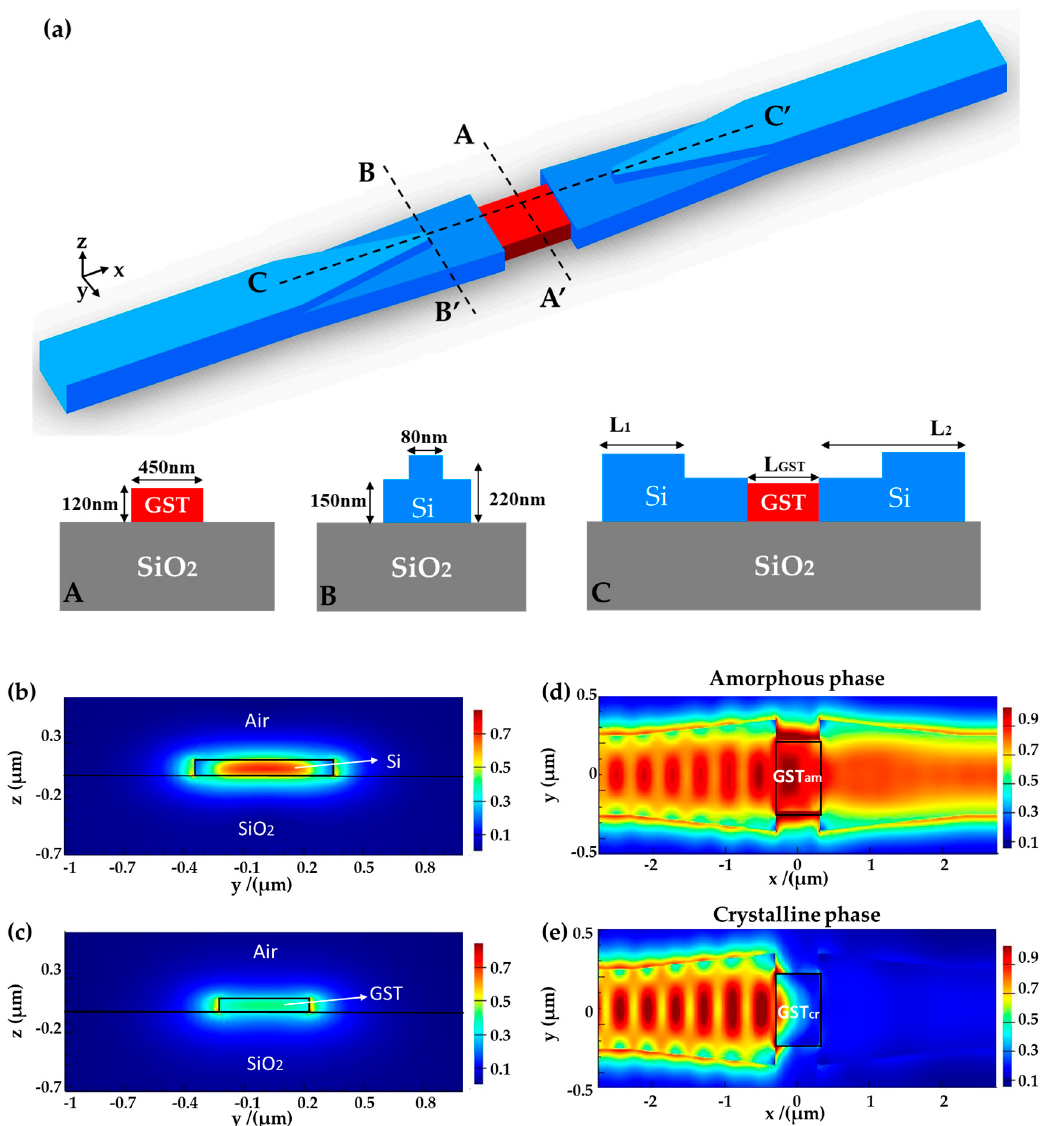
Figure 6. ( a ) Three-dimensional view of the revised design. The insets show cross-sectional views along the segments AA’, BB’, and CC’. ( b , c ) Electric-field intensity profiles of ( b ) the silicon waveguide and ( c ) the amorphous GST waveguide across the interface. ( d , e ) Electric-field intensity distributions in the horizontal plane along the waveguide when GST is at ( d ) the amorphous and ( e ) the crystalline states.